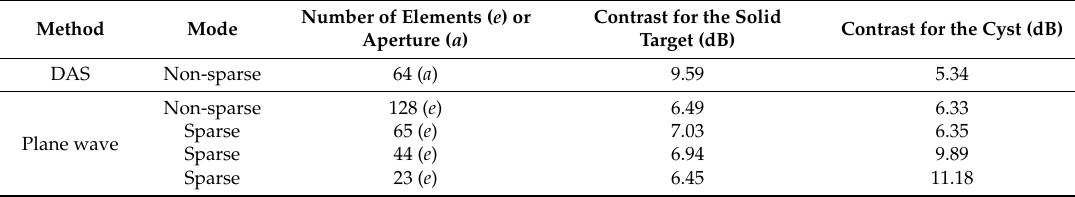
Table 4. Contrast analysis for the solid and cyst targets shown in Figure 12 with the data processed using the DAS method and plane wave without and with sparsity in the reception.